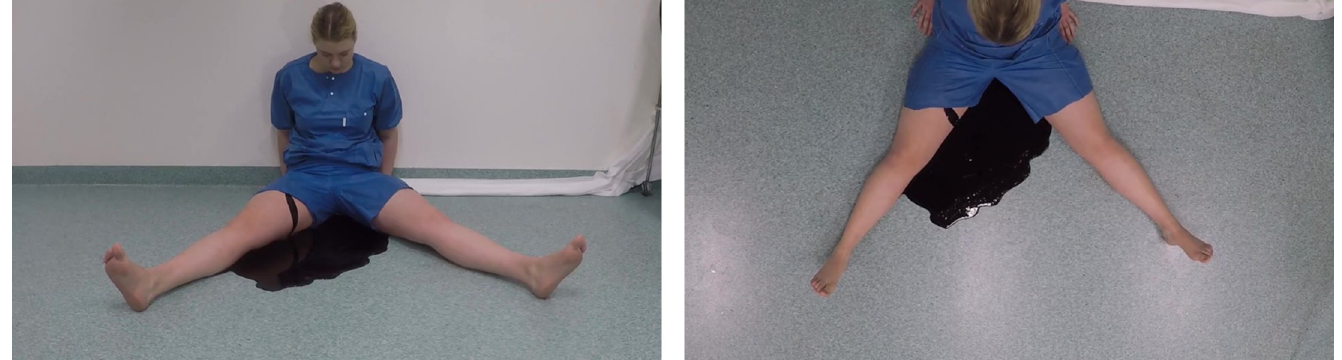
Fig 1. Example stimuli. Images showing the female actor from the front (left) and top (right) perspectives. The blood loss in this figure does not correspond to a specific volume used in the experiment. The individual shown in this figure has given written informed consent (as outlined in the PLOS ONE consent form) to publish these